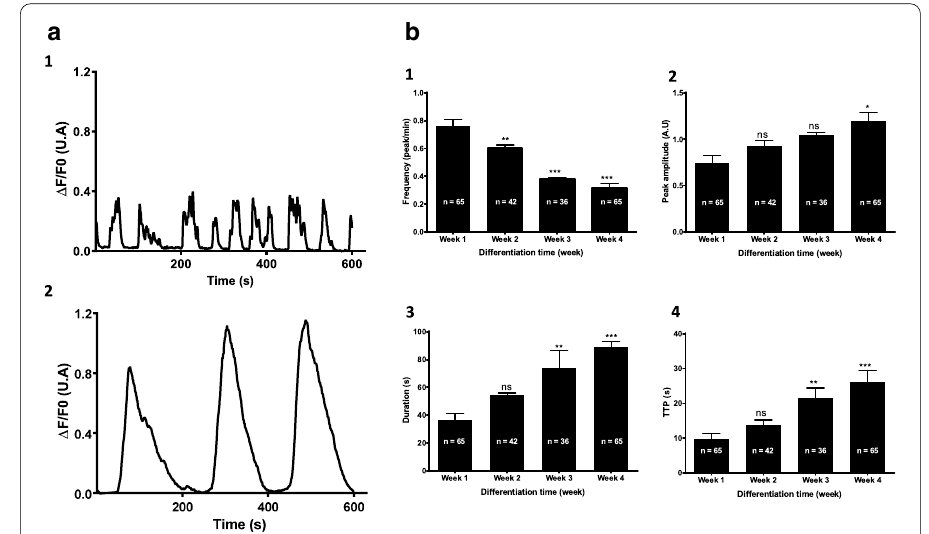
Fig. 2 Evolution of spontaneous calcium activity parameters during W8B2 + CSC differentiation. a Types of spontaneous calcium activity recorded at the beginning of the differentiation process [day 2 after differentiation (1)] and at the end of the differentiation process [day 28 after differentiation (2)]. The graphs illustrate variations in [Ca 2 + ] i represented by ΔF/F0 ratio, where F0 represents the basal fluorescence emitted by the GCaMP, and ΔF the difference between basal and actual fluorescence (F) at a given time point. b Bar graphs (1), (2), (3), (4) represent the evolution of the frequency, the peak amplitude, the duration and TTP (time to peak) of calcium oscillations, respectively, recorded during the 4 weeks of W8B2 + CSC differentiation. (N 6 patients, n: represents the number of cells analyzed, AU: arbitrary unit, ns: not significant). *p < 0.05, = **p < 0.01, ***p < 0.001 vs. week 1; one‑way ANOVA followed by a Newman‑Keuls